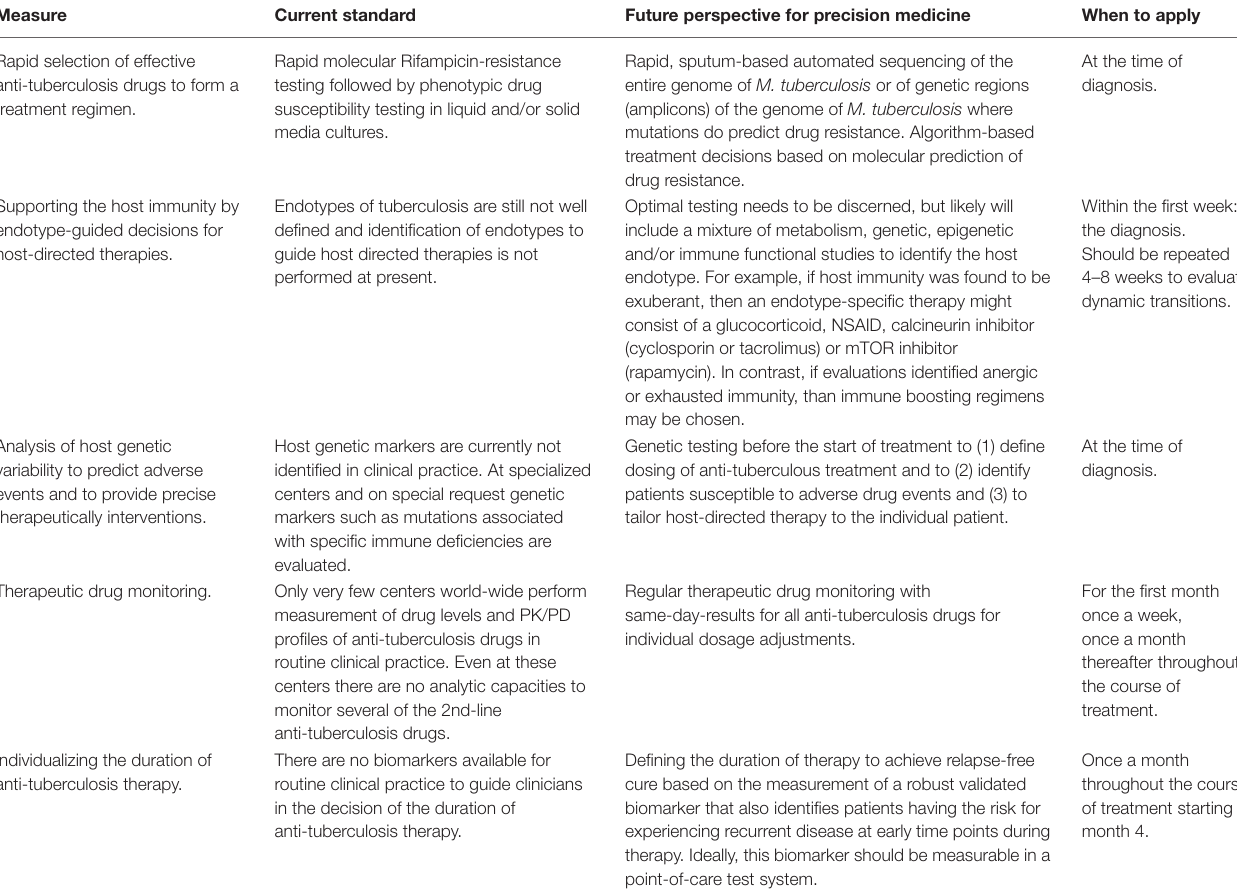
TABLE 1 | Current standards and future perspectives for Precision Medicine for tuberculosis.